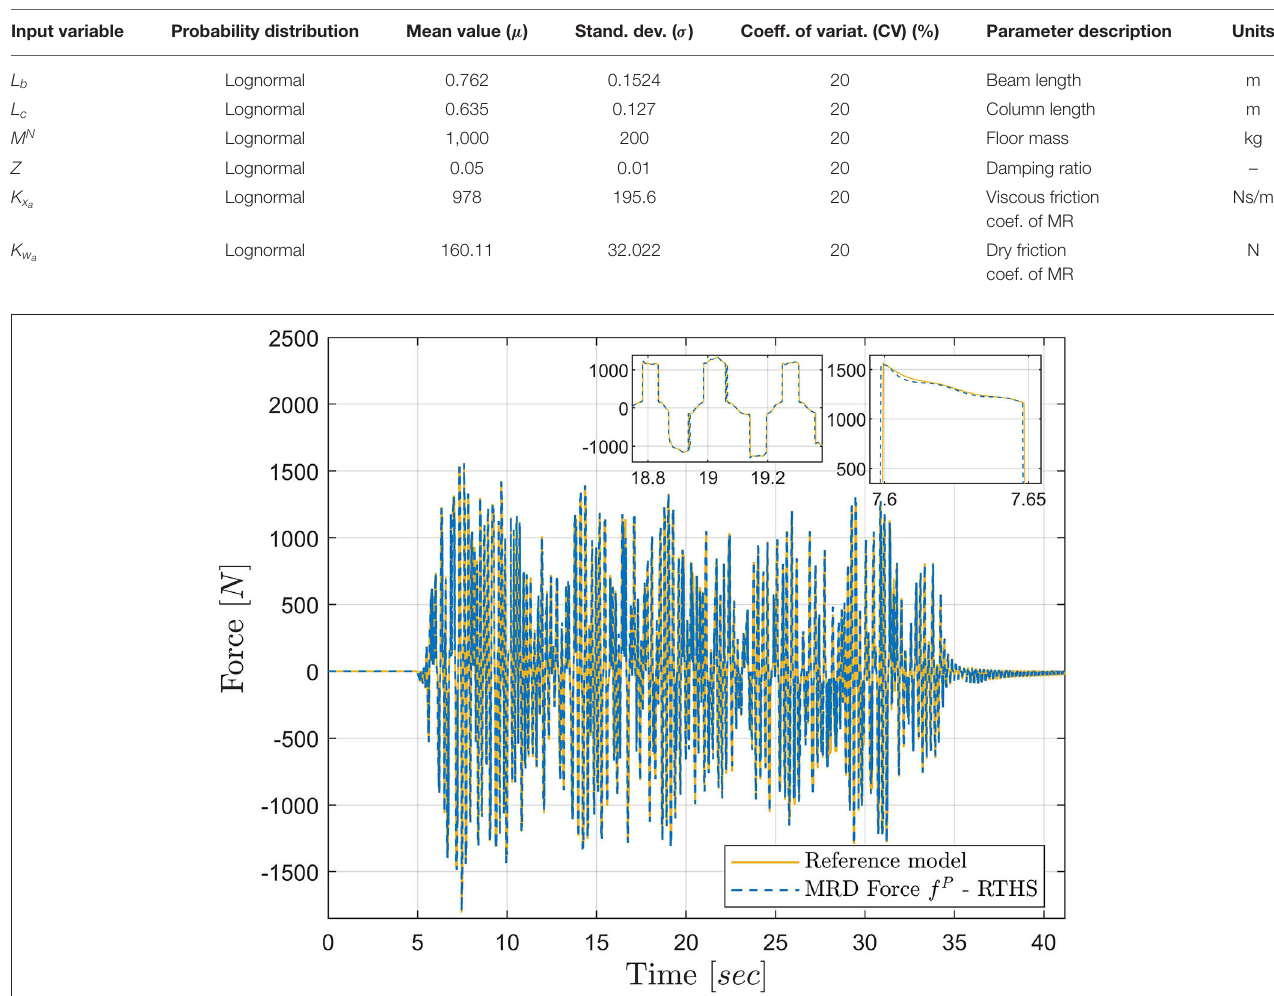
TABLE 3 | CS2: Variation of the random parameters in the hybrid model.